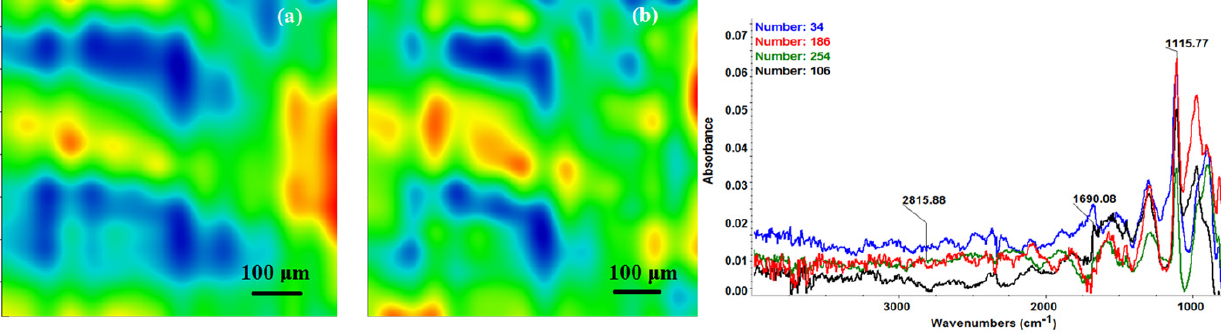
− 1 − 1 and ( b ) 1689 cm .